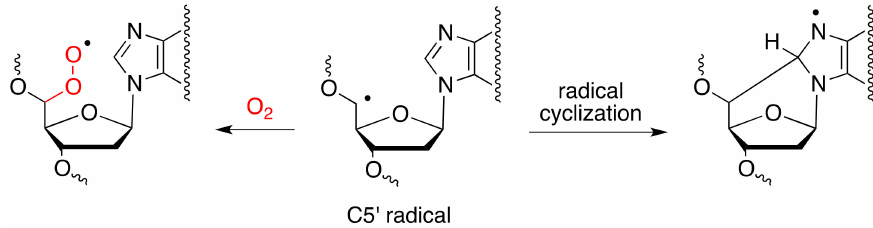
Figure 2. Partition of C5 (cid:48) radical between cyclization and addition to molecular oxygen.